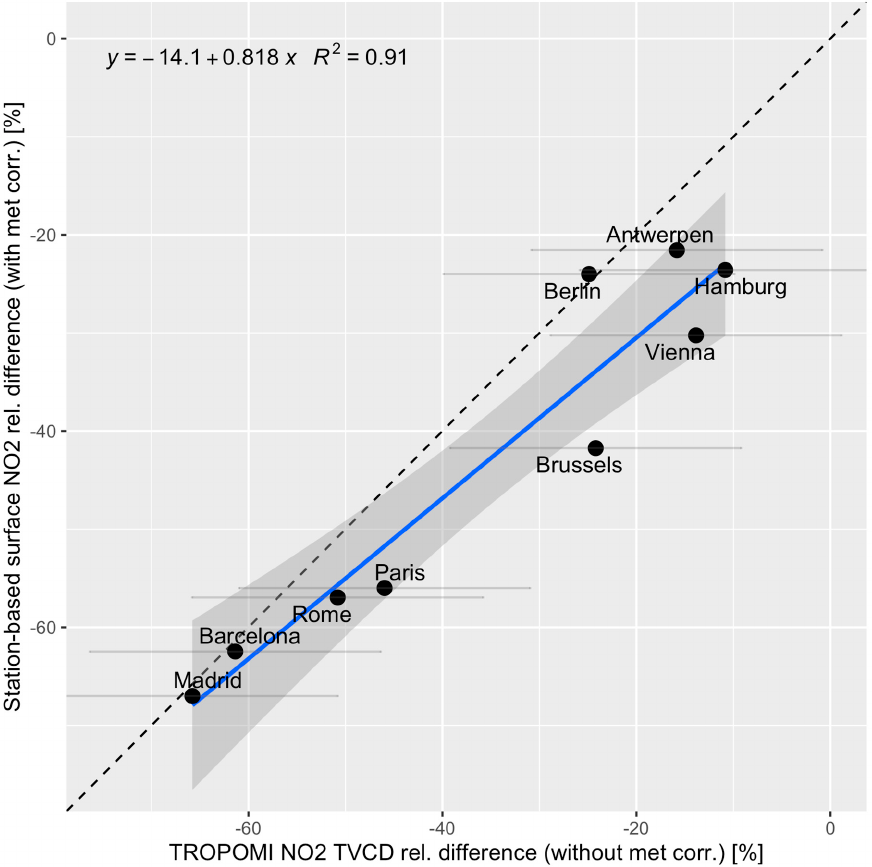
Figure 13. The relative difference in the tropospheric vertical NO 2 column density as observed by the TROPOMI instrument on Sentinel-5P for April 2020 versus the GAM predicted relative reduction in surface NO 2 concentration at traffic sites in various European cities. Gray horizontal lines represent the approximate uncertainties of the satellite estimates, including the effect of meteorological variability. The dashed black line indicates the 1:1 reference